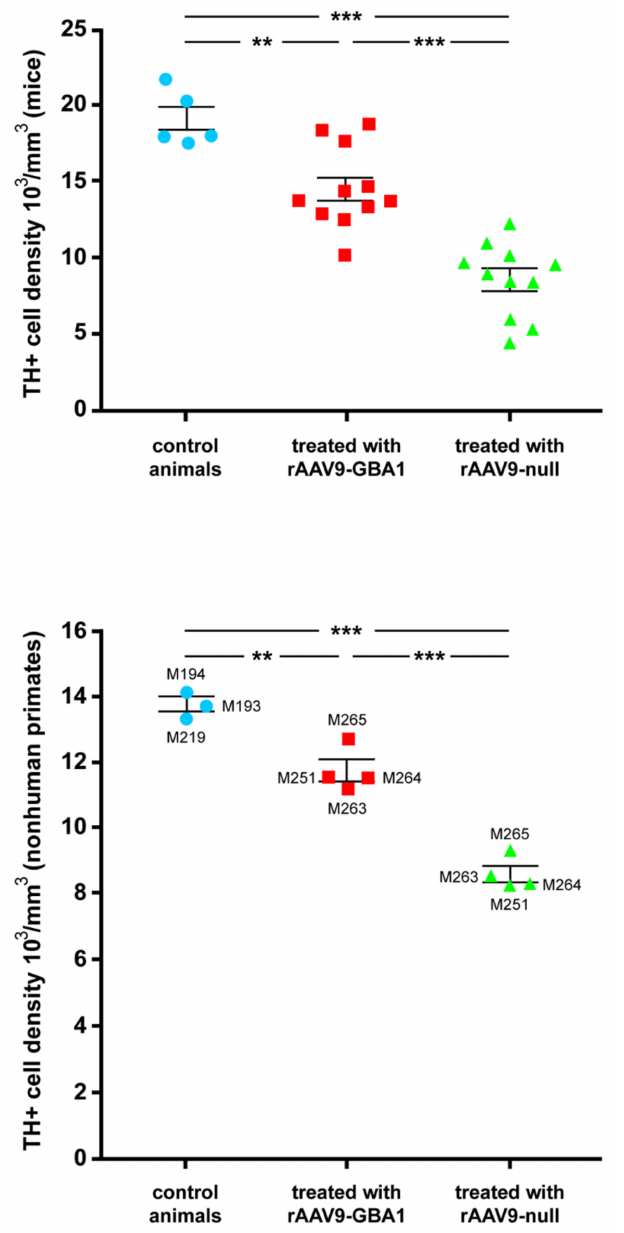
Figure 2. Unbiased stereological estimation of TH-ir neurons in the SNpc. Top: results gathered from mice experiments. The mean baseline density of TH-ir neurons was calculated in 5 naïve mice (blue dots and bar) and used for comparison purposes of mice treated with rAAV9-GBA1 (red dots and bar) and with rAAV9-null (green dots and bar). Eight weeks post-delivery of rAAV9-SynA53T, an average loss of TH+ cells of 55.1% was found in the SNpc upon treatment with the control vector, contrasting with 23.6% of TH+ neuronal density found in the right SNpc (e.g., the one treated with rAAV9-GBA1). Bottom: stereological estimation of the density of TH+ neurons in the nonhuman primate SNpc. Three control naïve NHPs were used to estimate the baseline TH+ neuronal density (blue dots and bar). Within the right SNpc (treated with rAAV9-null vector), a TH+ cell loss of 38.1% was found with a follow-up of 3 months post-injection of rAAV9-SynA53T, whereby cell loss was reduced to 14.9% on average in the SNpc injected with rAAV9-GBA1. Statistical comparisons were found to be highly significant for all groups ( p < 0.05 for comparisons between control groups and animals treated with rAAV9-GBA1; p < 0.001 for comparisons between treated and untreated animal groups; p < 0.001 for comparisons between control groups and animals treated with rAAV9-null). **: p < 0.01; ***: p <